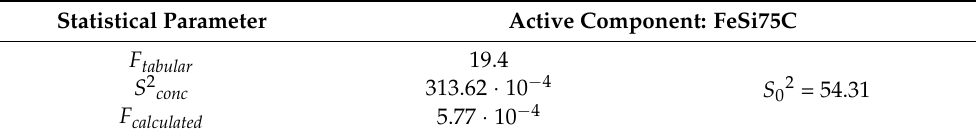
Table 5. Statistical verification of the adequacy of the adopted mathematical